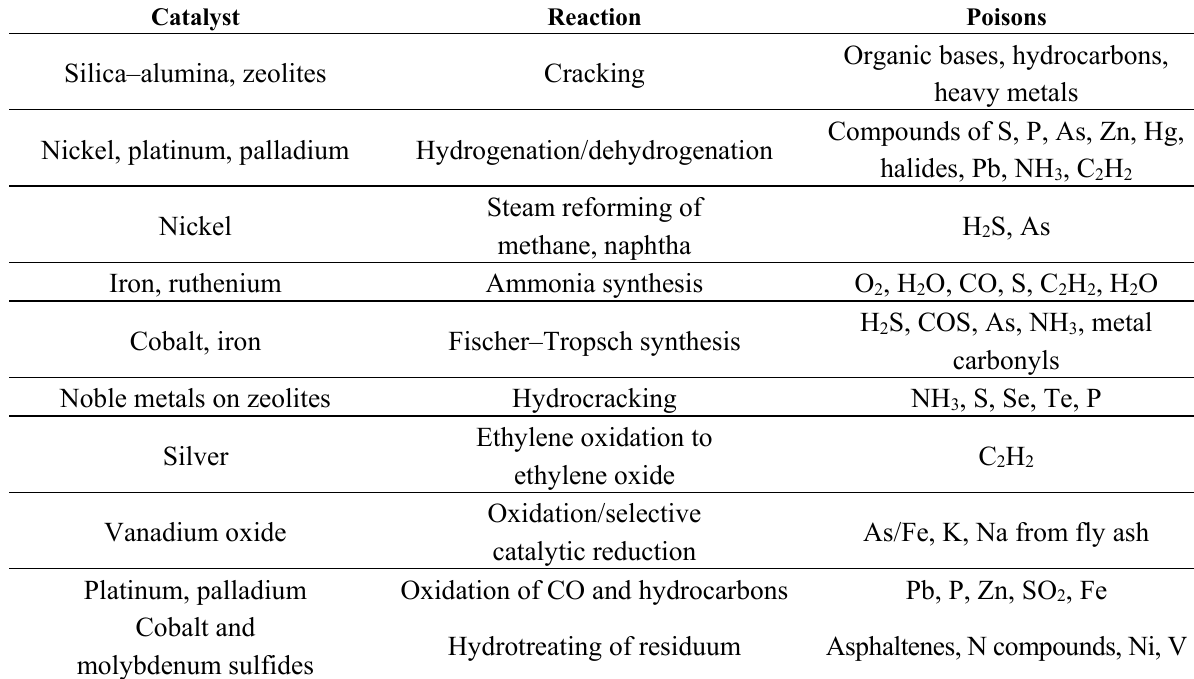
Table 3. Poisons for selected catalysts in important representative